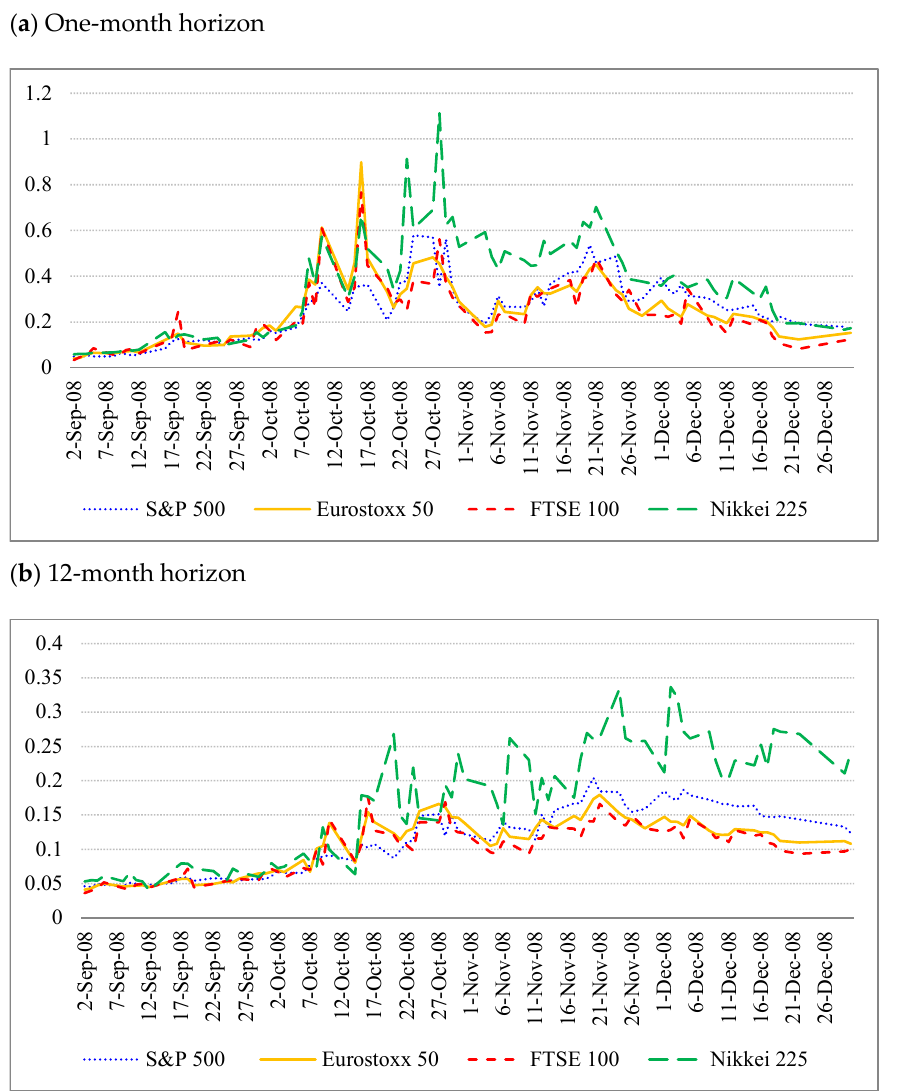
Figure 7. Expected Market Risk Premia: The Great Recession. This figure displays the time series behavior of the expected market risk premia estimated from option prices with four alternative underlying stock indexes: the S&P 500, Euro Stoxx 50, Nikkei 225, and FTSE 100. The expected risk premia are estimated daily following Martin (2017) and using options with maturities of one month ( a ) and 12 months ( b ). The sample period comprises the four months with the worst stock market results during the Great Recession from September 2008 to December 2008.